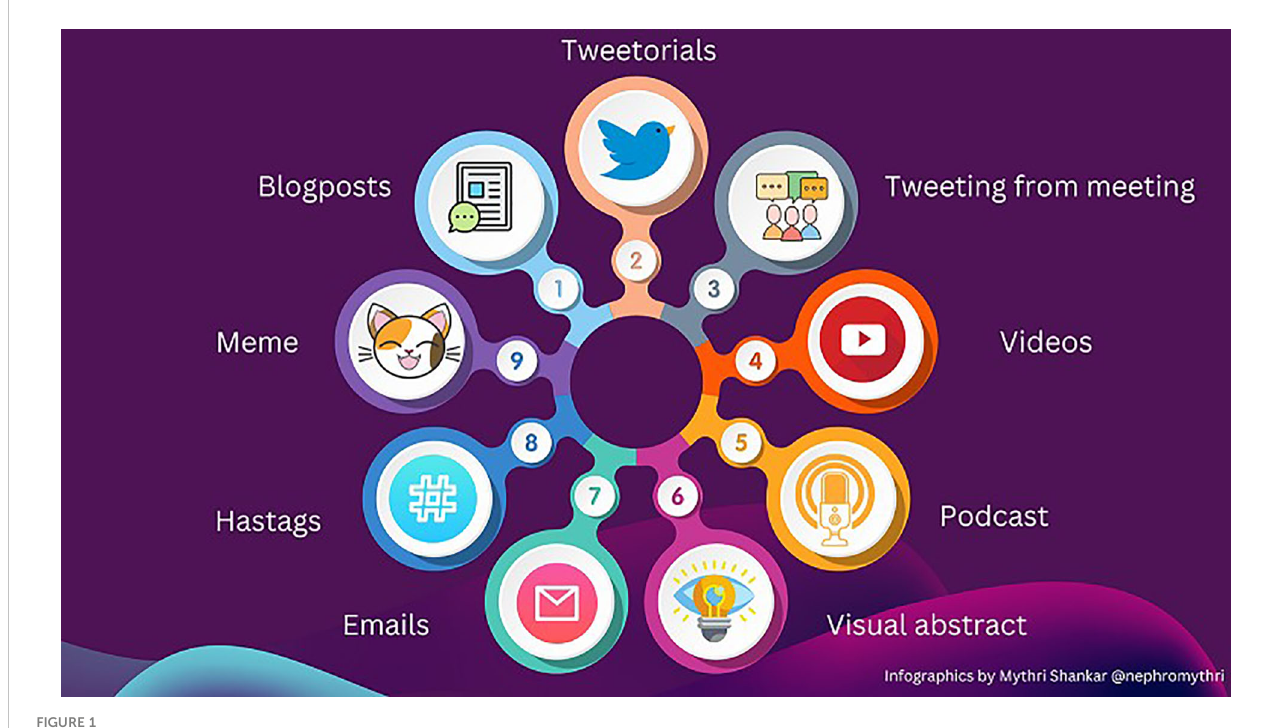
FIGURE 1 Various modes of social